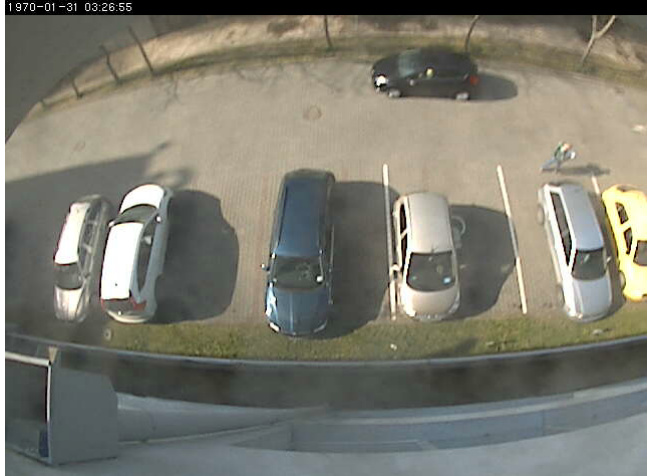
Figure 5. Field of vision of Camera A used in the experiments.